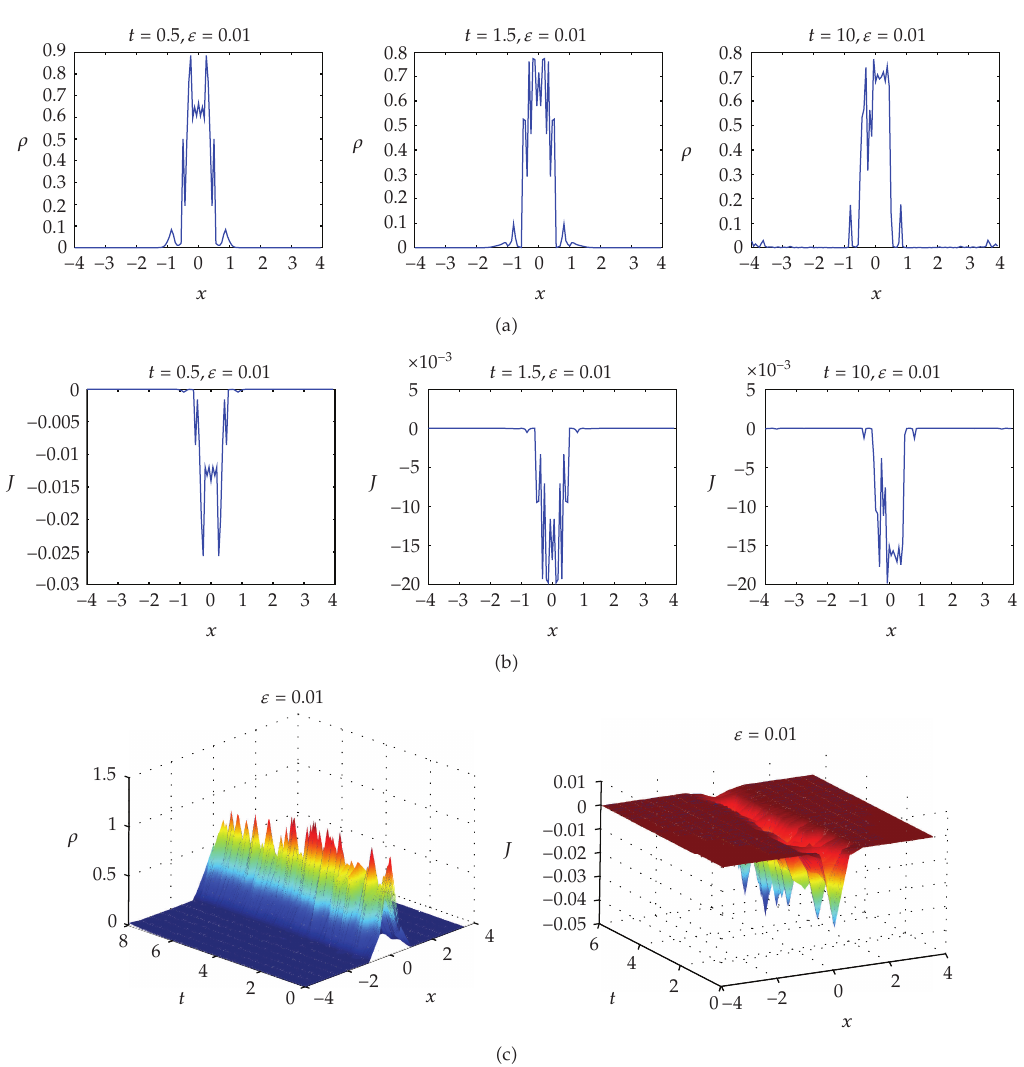
Figure 11: Numerical solutions of Example 5.3 by ED2/EP2 for the strong O (cid:3) 1 (cid:4) cubic defocusing nonlinearity (cid:3) λ (cid:6) 1 (cid:4) , ε (cid:6) 0 .